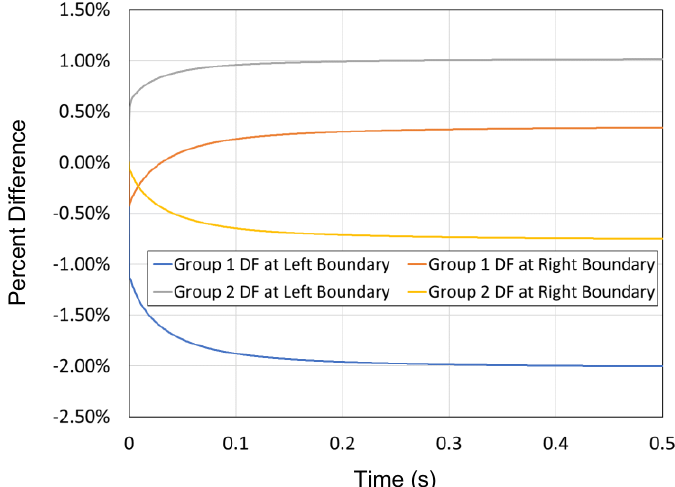
Figure 9. Variation in Time of the Discontinuity Factors for Node 14 with Respect to the Steady State